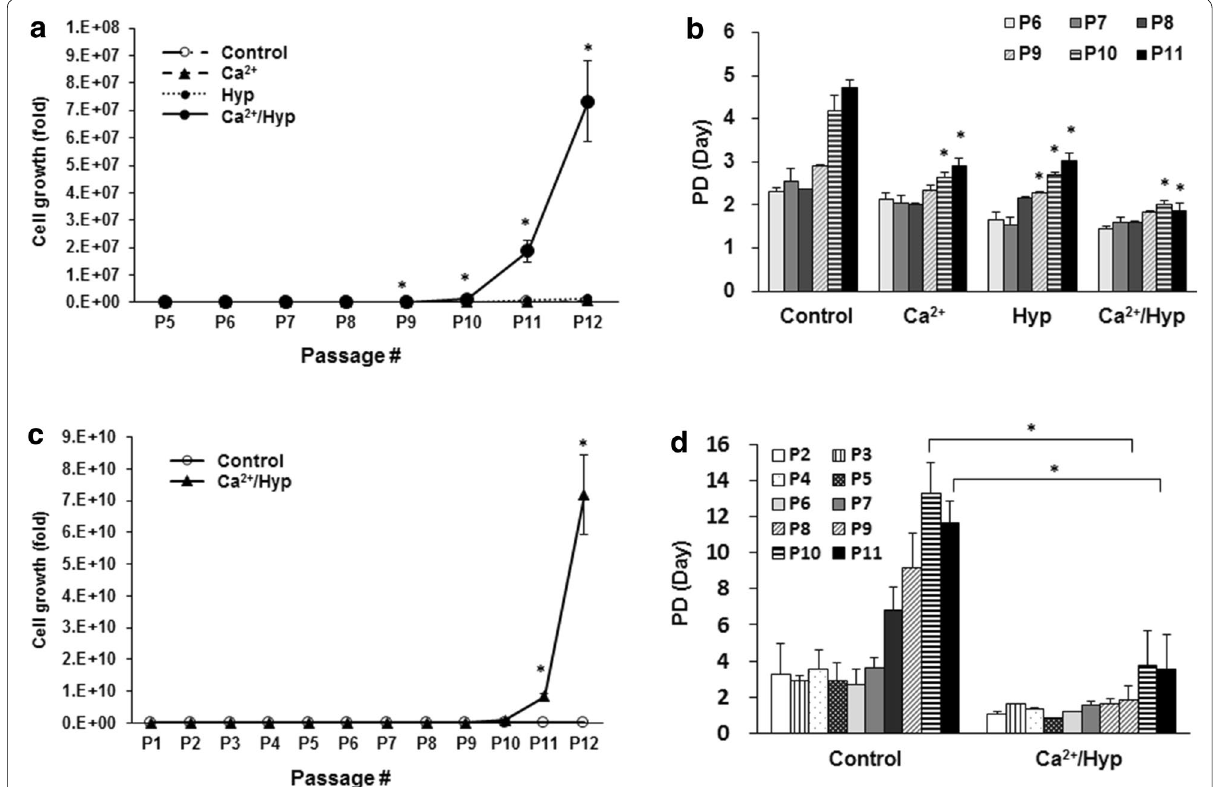
Fig. 2 Ca 2 + /hypoxia‑treated hUCB‑MSCs maintained their proliferation capacity in long‑term culture. a , b Growth curves and population doubling (PD) time of hUCB‑MSCs in individual treatments were analyzed for all passages during long‑term culture. c , d After isolation of MNCs from UCB, the cells were maintained under the two culture conditions. Growth curves and PD time were analyzed for hUCB‑MSCs treated with Ca 2 + /hypoxia through a series of passages. The initial cell concentration of hUCB‑MSCs was 5 10 3 cells/cm 2 . Cell proliferation was measured by cell counting × assays. Data represent the mean SD, n 3; * P < 0.05 versus ± =